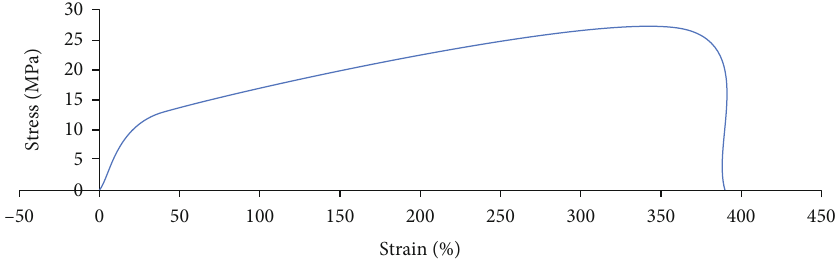
Figure 4: Polycaprolactone polymer ( T